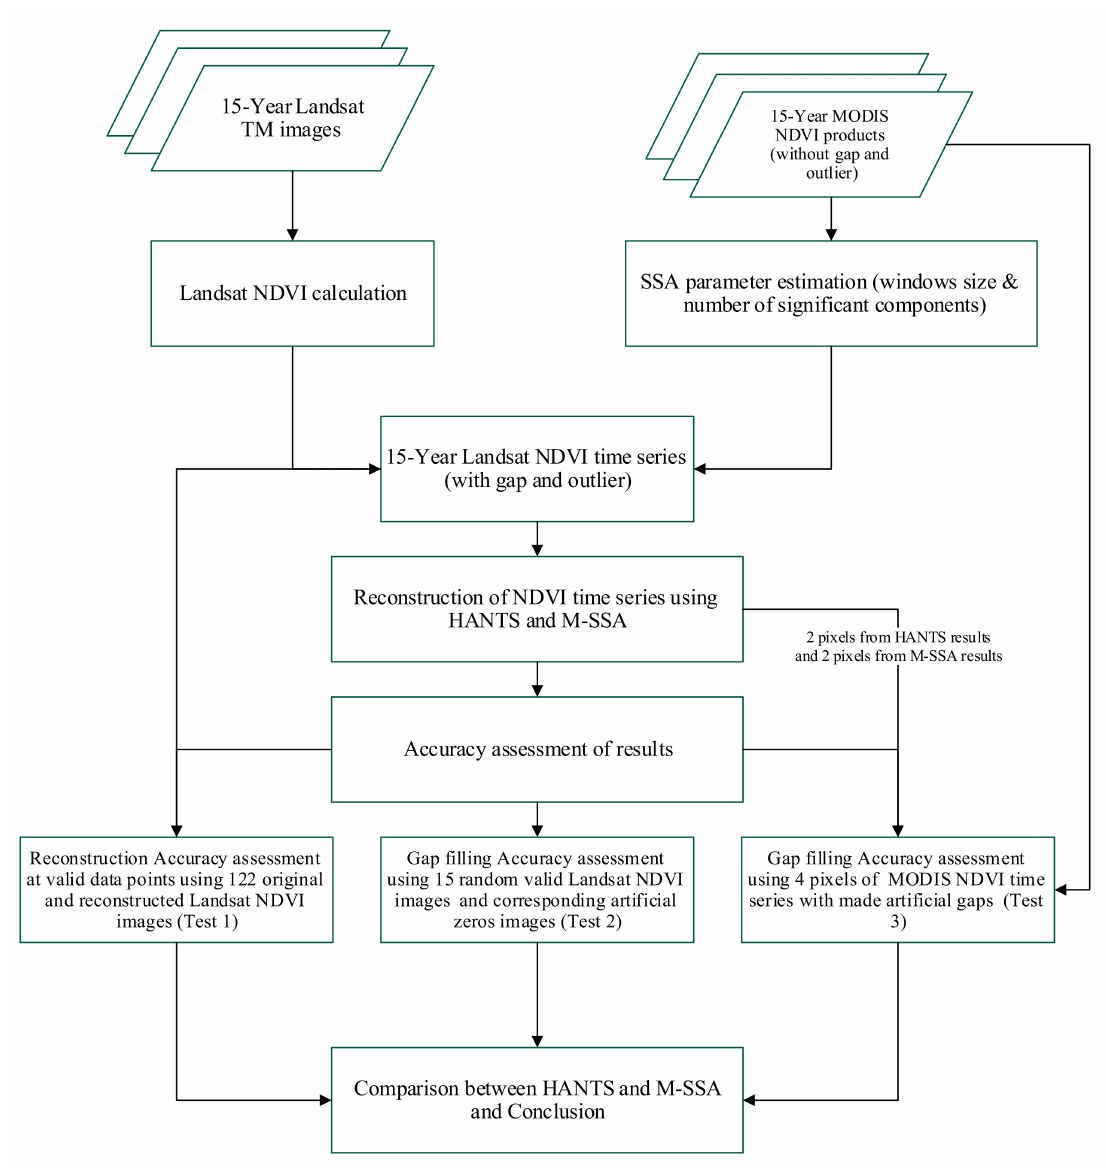
Figure 4. Flow chart of the main processes of this